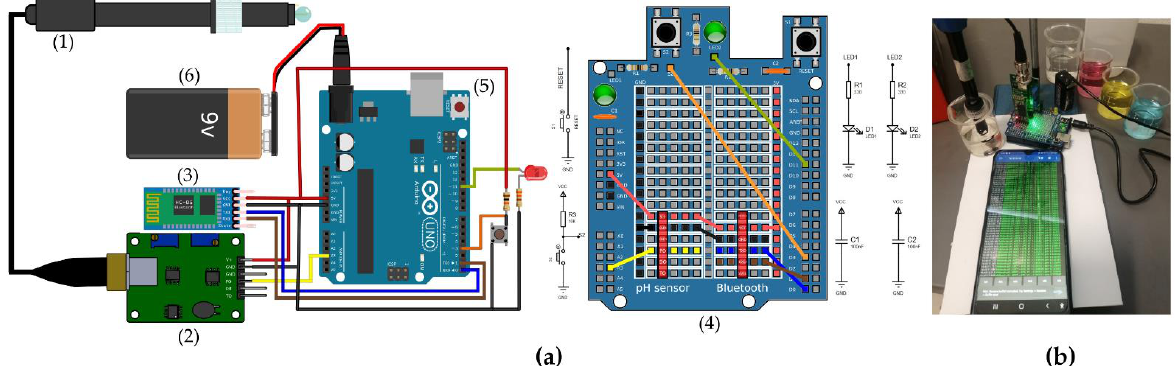
Figure 4. ( a ) The pH instrumentation for global VF applications consists of six main components: (1) Glass electrode; (2) Signal conditioning module; (3) Bluetooth communications module; (4) Integration breadboard; (5) Signal acquisition and processing module; and (6) Power supply. ( b ) Representative photo.